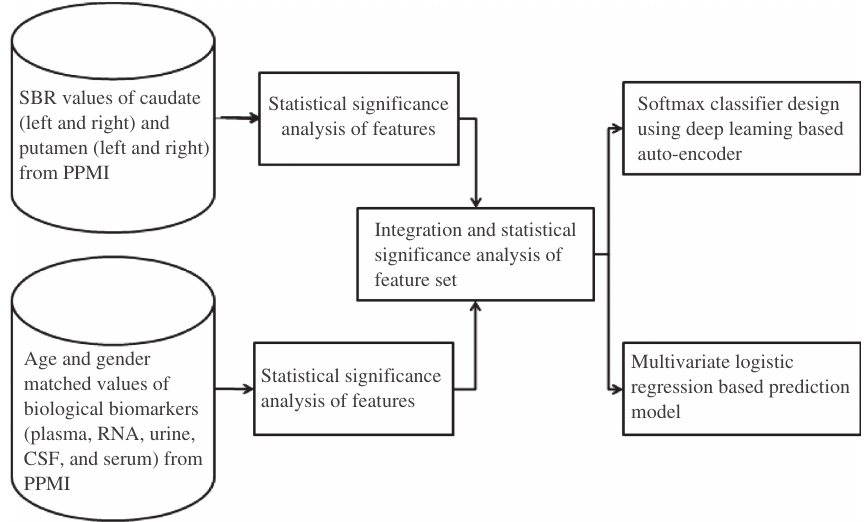
Figure 1: Steps of the Analysis Carried Out for Classification/Prediction of PD